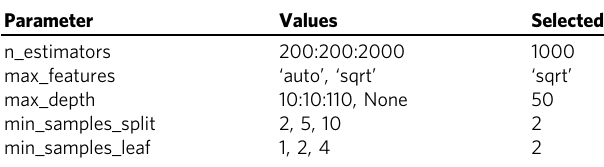
Table 1 Tested parameter grid for random forest classi fi